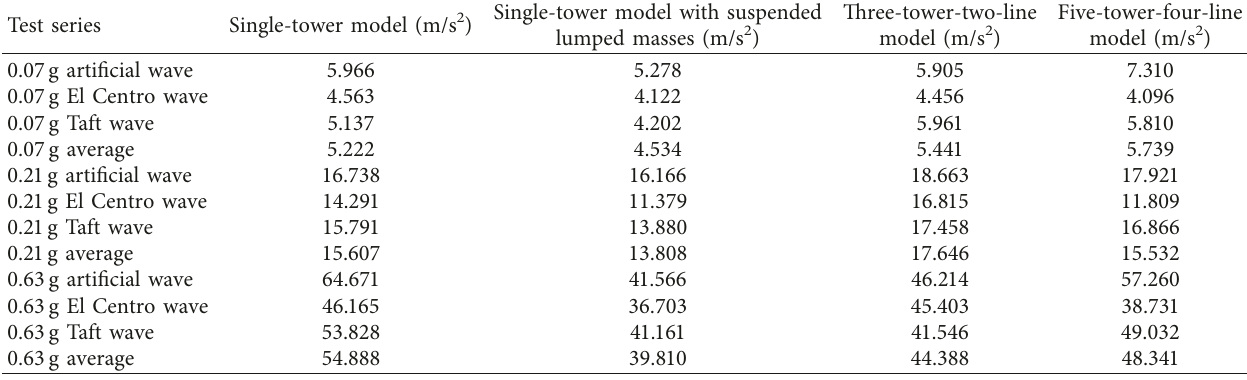
Table 5: Longitudinal peak acceleration responses of the middle towers of the four models.